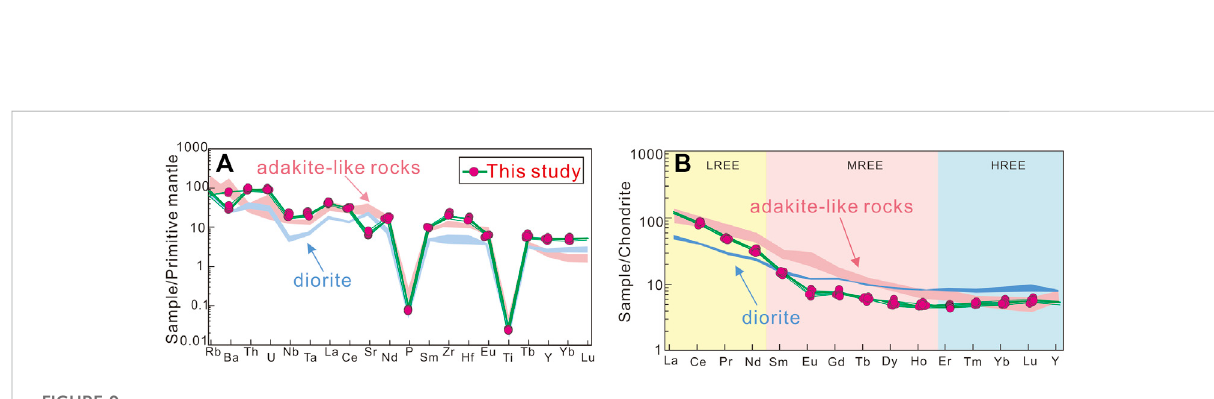
FIGURE 9 (A) Primitive mantle-normalized multiple trace element diagram. (B) Chondrite-normalized REE patterns (normalized values are after Sun and McDonough, 1989) (the Early Cretaceous diorite data from Wang et al., 2013; the Early Cretaceous adakite-like rocks data from Zhu et al.,